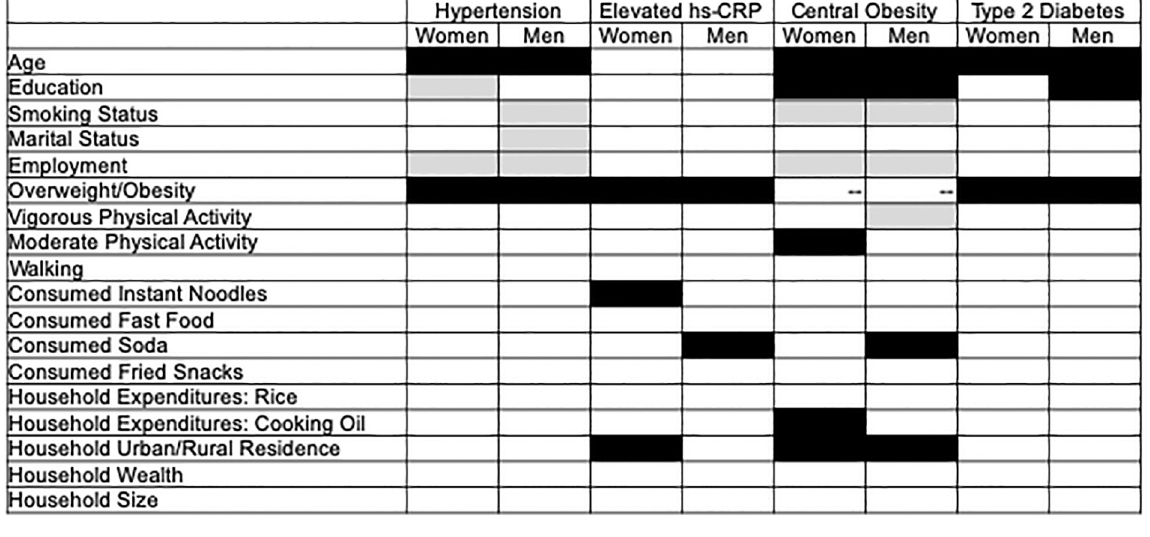
0.52, 0.97) or skilled labor (OR = 0.70; 95% CI: 0.53, 0.94) were also associated with lower odds